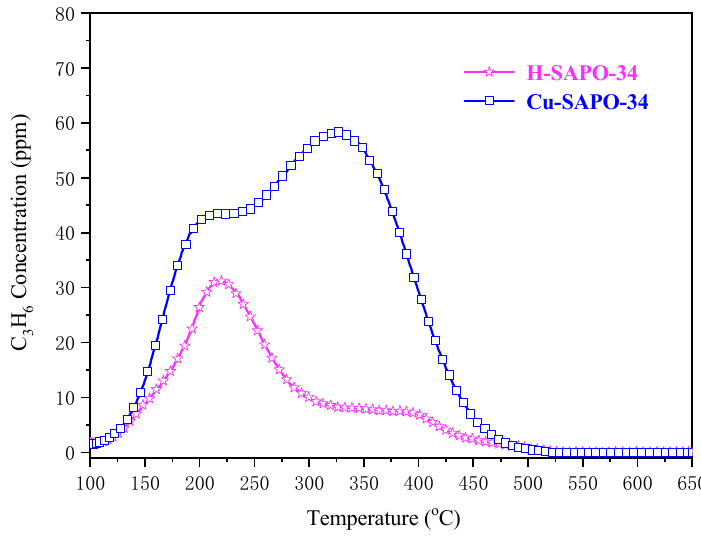
Figure 8. C 3 H 6 -TPD profiles over H-SAPO-34 support and Cu-SAPO-34 catalyst.